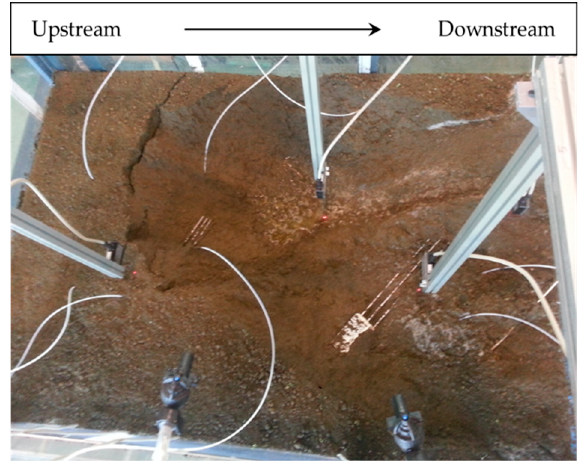
Figure 15. Deposit at the end of the test.